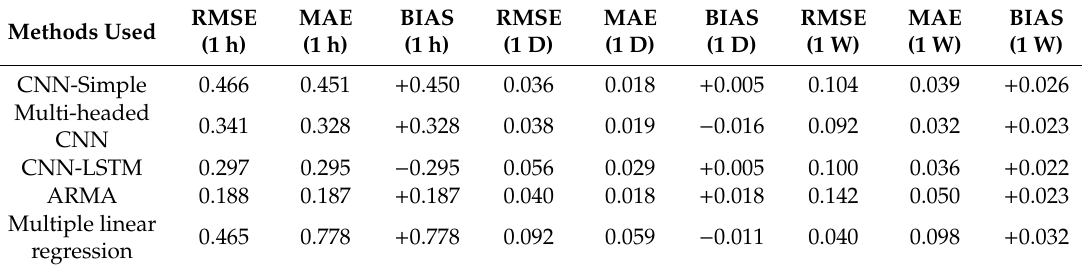
Table 3. Forecast metrics for the short and long term during the winter months.